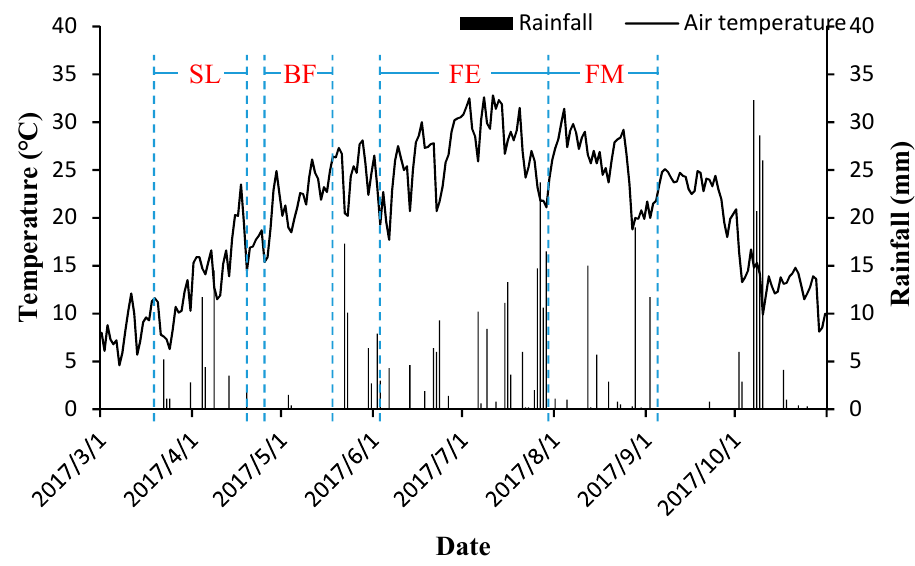
Figure 1. Rainfall distribution and temperature from March to October in 2017 (SL: sprouting and leaf expansion stage; BF: blossoming and fruit-bearing stage; FE: fruit expansion stage; FM: fruit maturity stage. The labels are the same below.).